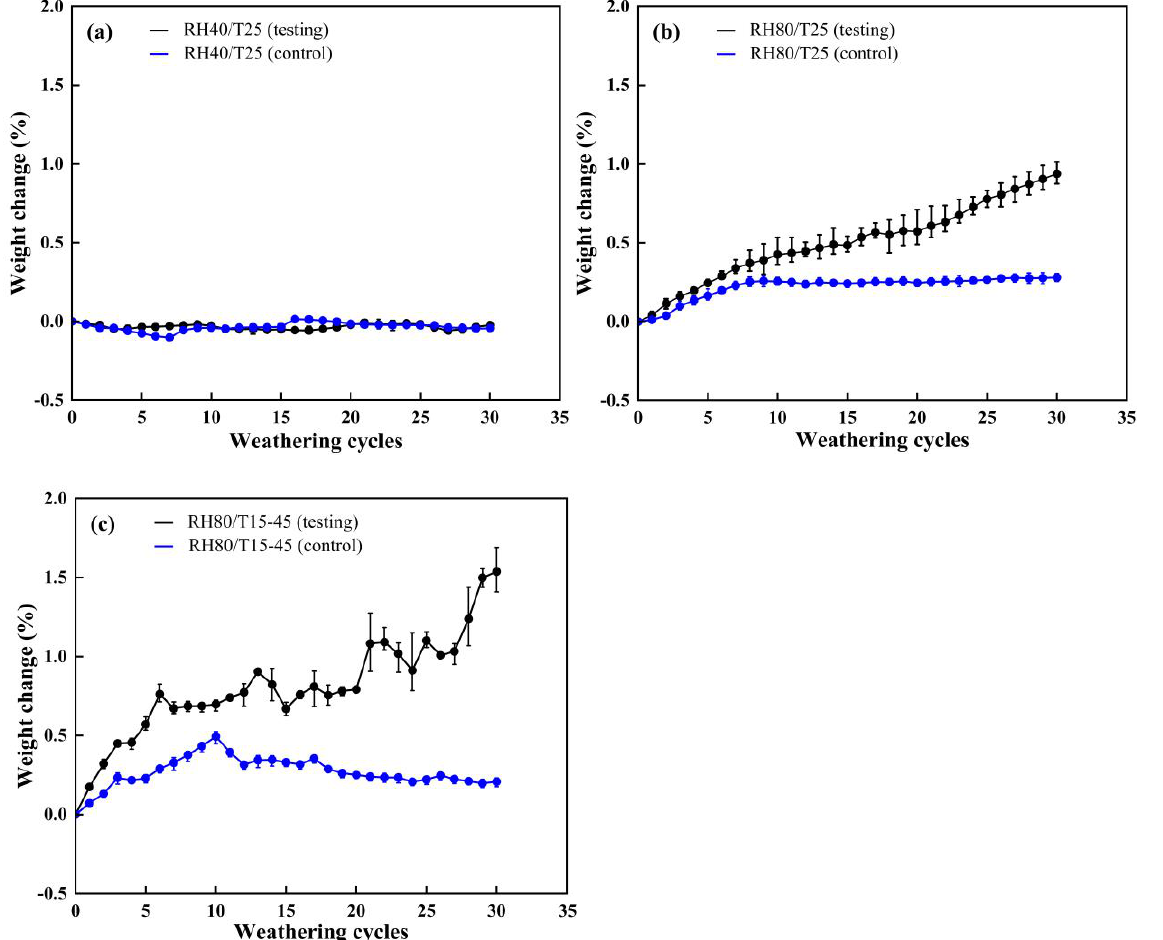
Figure 8. Weight change of sandstone specimens during weathering tests: ( a ) RH=40%, T=25 ℃; ( b ) RH=80%, T=25 ℃; and ( c ) RH=80%, T=15 – 45 ℃ .